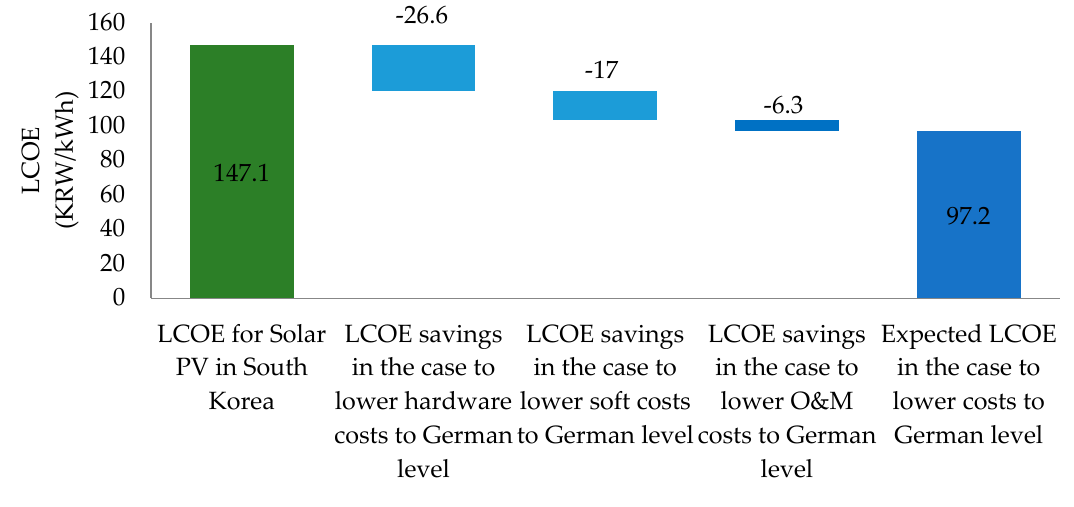
Figure 14. Commercial solar LCOE adjustment in South Korea after lowering costs to the level of Germany.